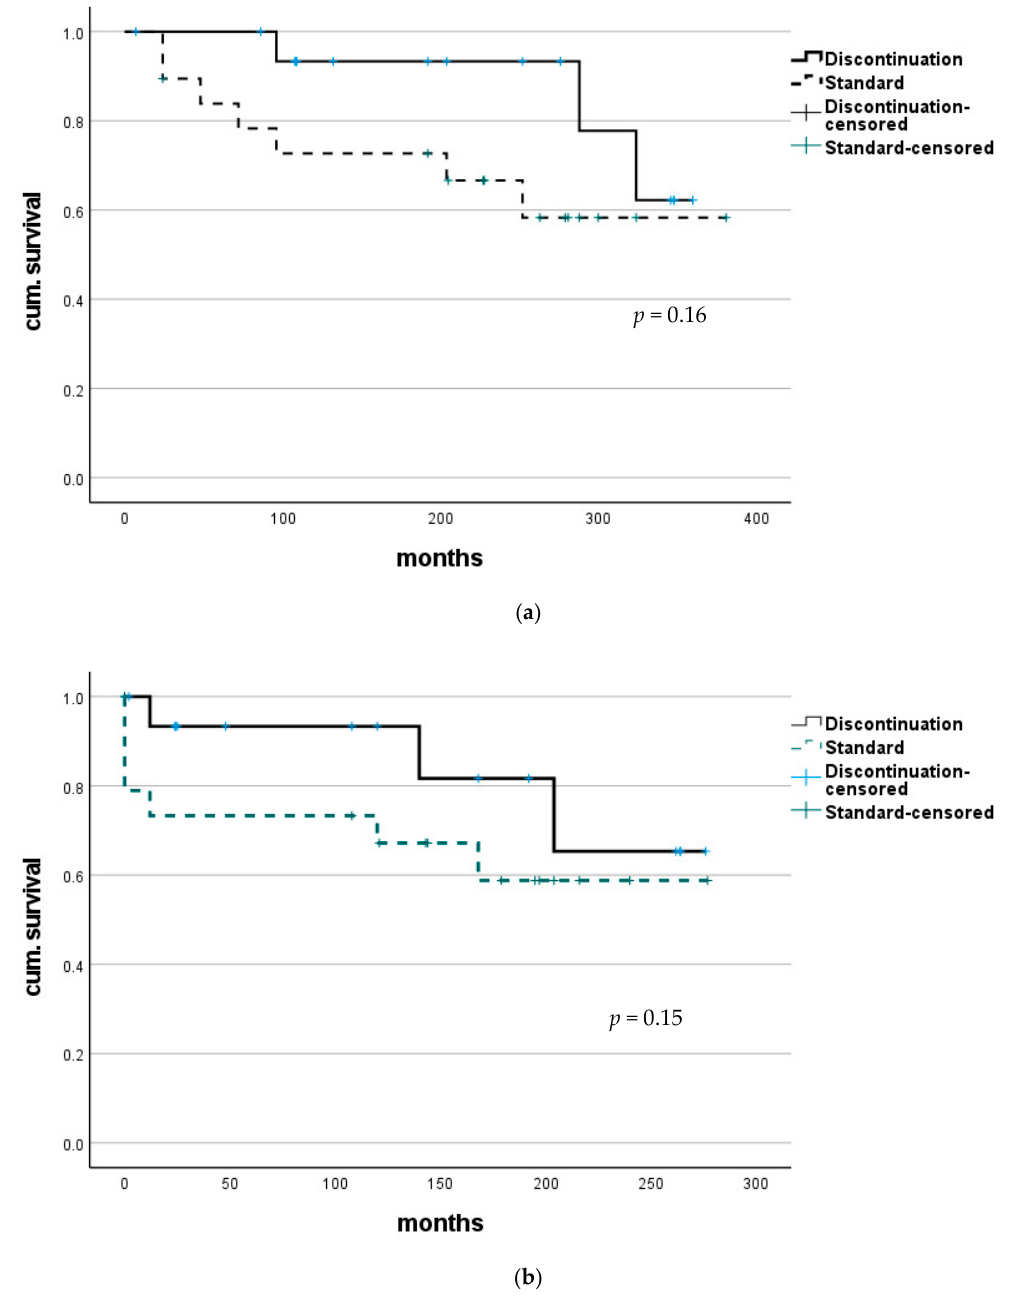
Figure 1. Survival after LT for combined HBV/HDV infection. ( a ) No statistically significant difference in overall survival was found between patients with continuous HBIG therapy (group Standard) and those where HBIG was eventually discontinued (group discontinuation). ( b ) Comparing survival after adjusting to a median time of discontinuation (72 months) to better evaluate course after HBIG discontinuation also did not show any significant difference.